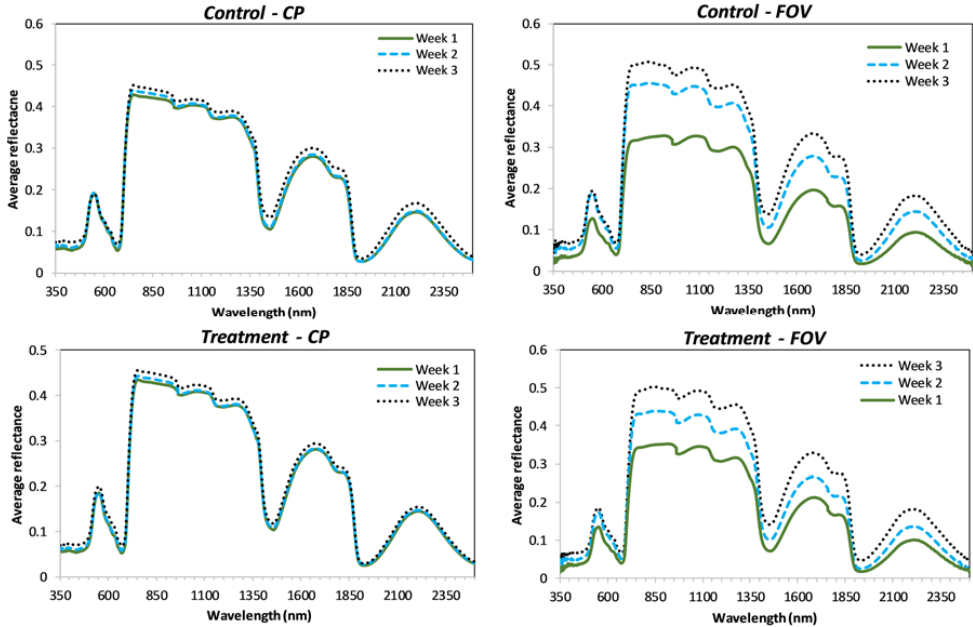
Figure A4. Control and treatment spectra for B. napus as acquired by CP and FOV.